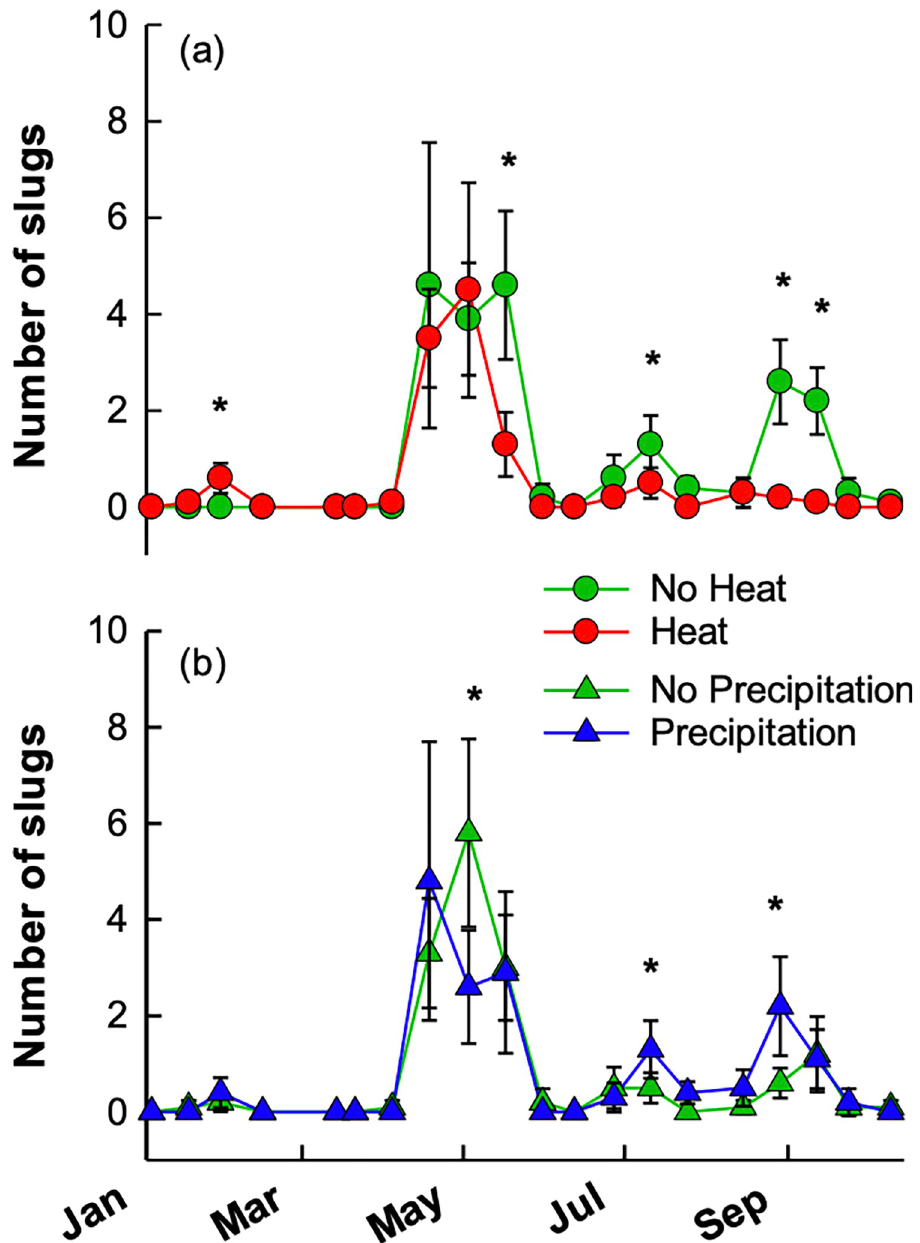
Fig 4. Average ( ± S.E.) number of slugs trapped in heated vs. non-heated plots (a) or in added precipitation vs. ambient precipitation plots (b). Points in time where significant climate treatment effects were observed are indicated by asterisks. Fescue growing season was March 15-October 15 with harvests occurring mid-May, early August, and mid-October. Seasons are defined as: winter—December-February, spring—March-May, summer—June-August, and